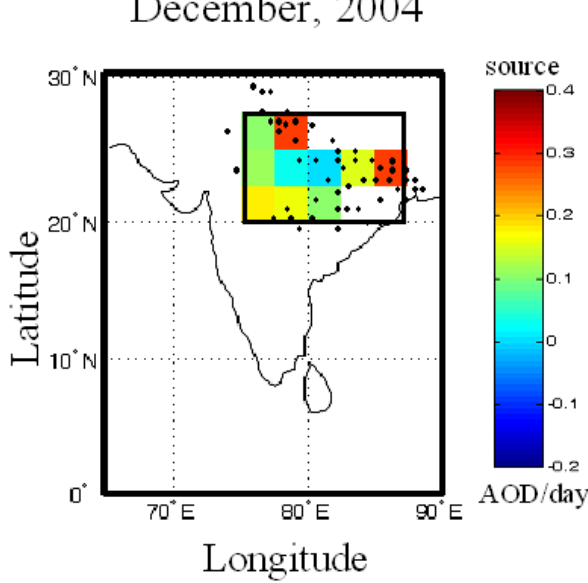
Fig. 6. Spatial distribution of mean source strength averaged for the month of December 2004 over the study domain.